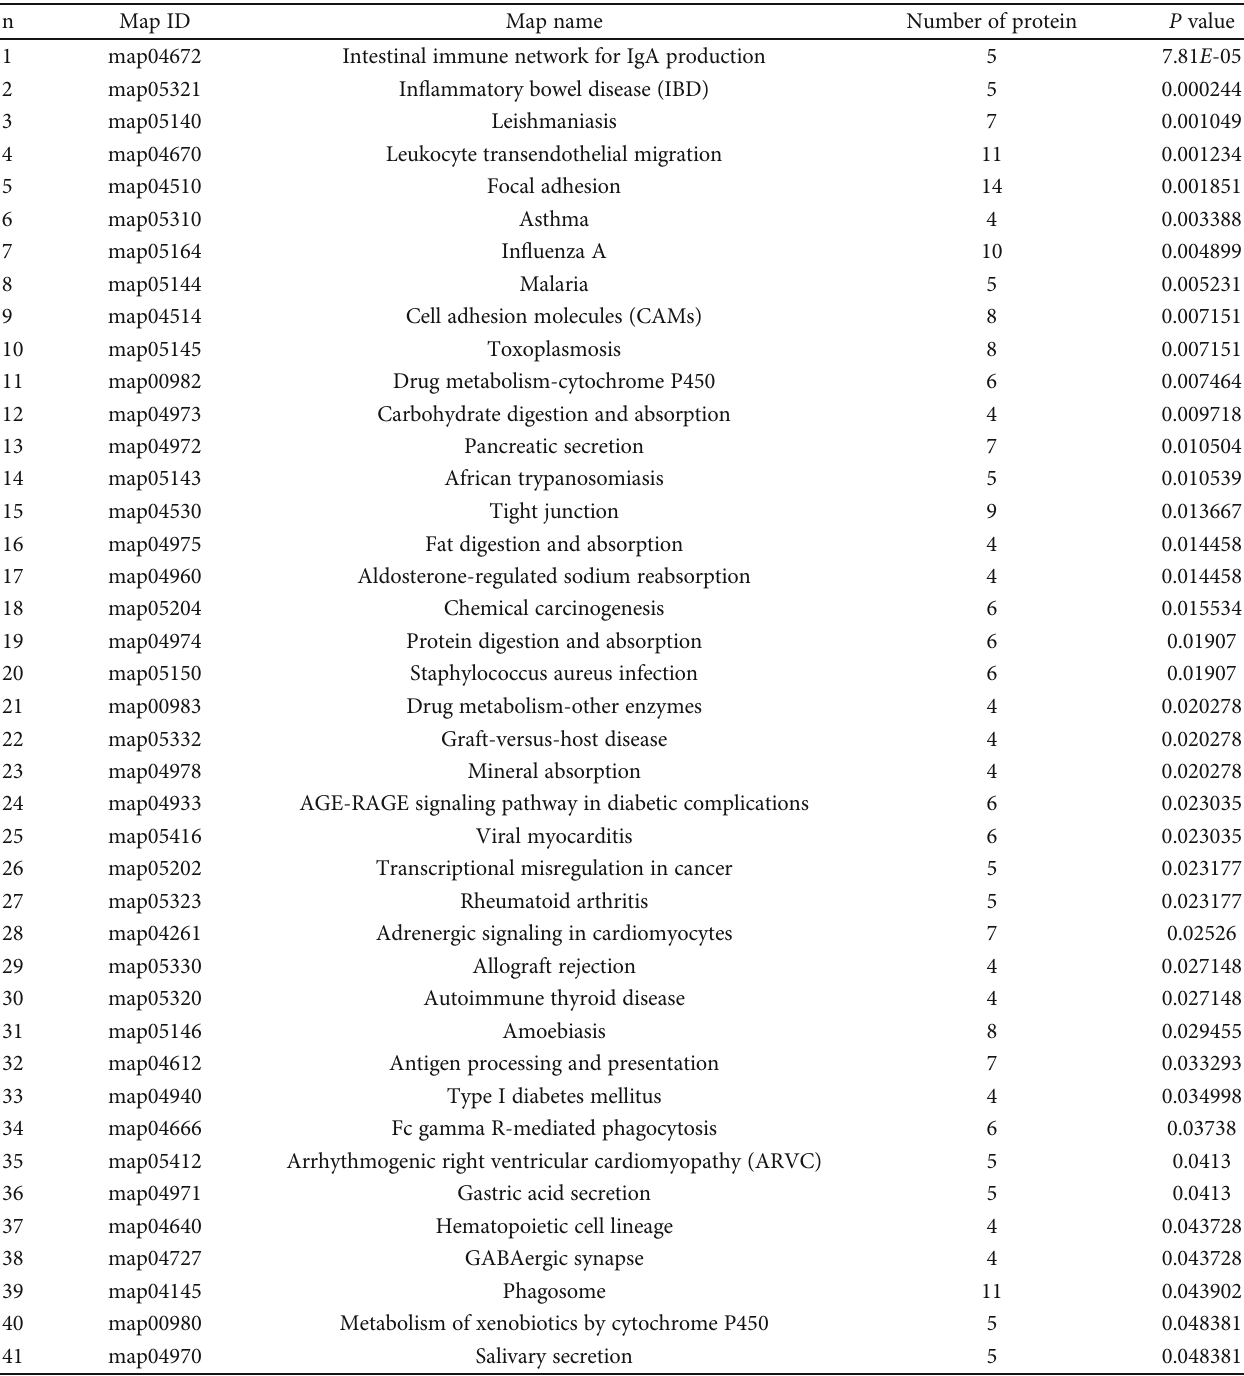
Table 3: Di ff erential protein enrichment in 41 KEGG metabolic